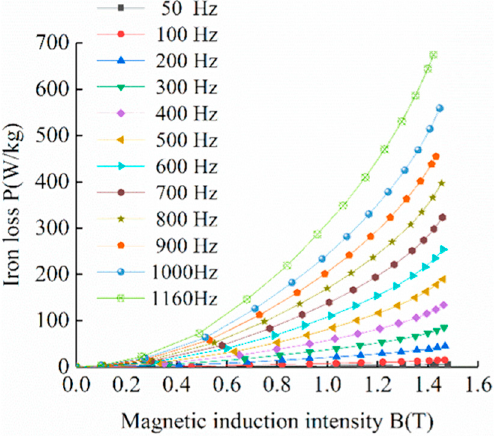
Figure 5. BP curve of 50W310 silicon-steel sheet at − 196 °C.